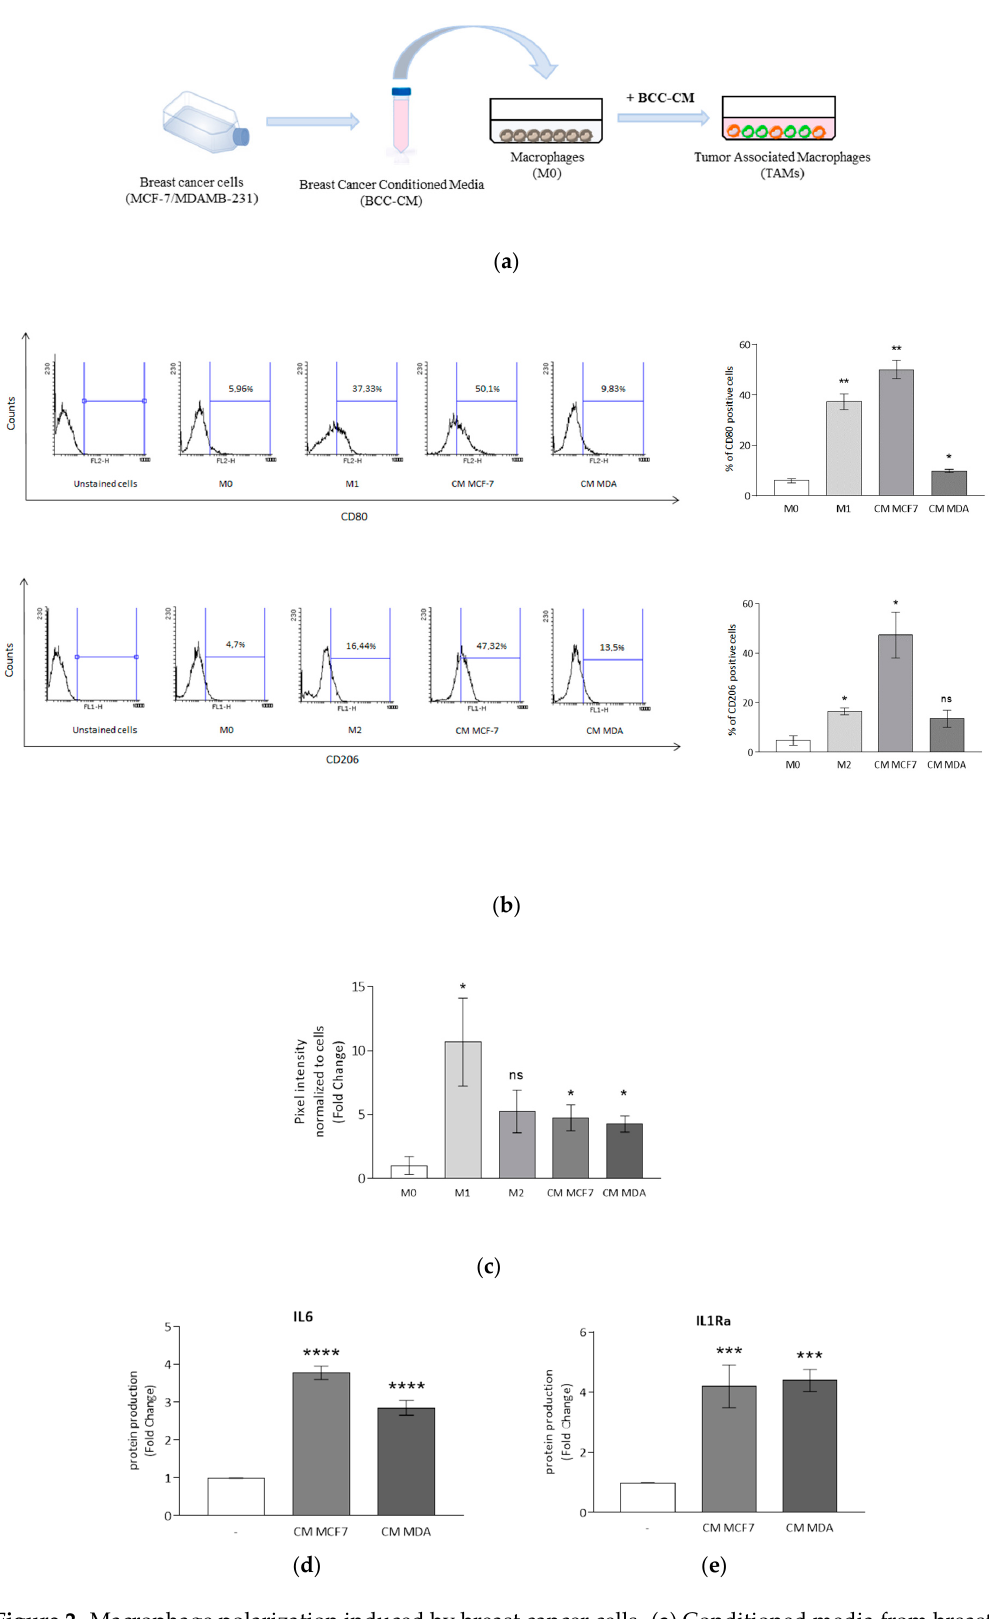
Figure 2. Macrophage polarization induced by breast cancer cells. ( a ) Conditioned media from breast cancer cells (BCC-CM) incubated in serum-free medium for 48 h were collected and added to M0 macrophages for 72 h to obtain tumor-associated macrophages (TAMs). ( b ) Flow cytometry analyses